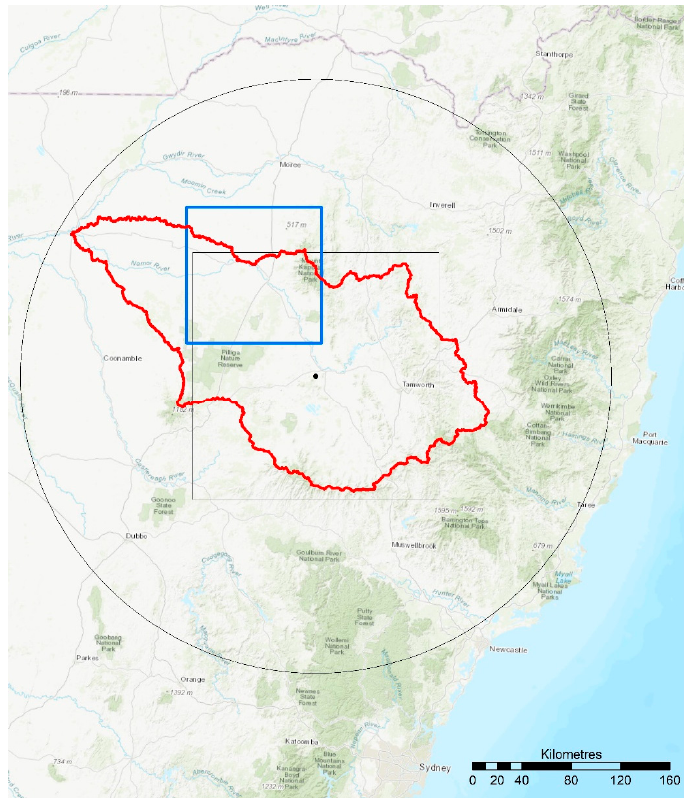
Figure 1. Map of the Namoi catchment and its surrounding. Depicted are the catchment (red line), the location of Namoi radar (black dot), the radar coverage after processing (radius of 240 km; black circle), the area used for the comparison of the different precipitation datasets with respect to spatial precipitation patterns (black rectangle) and the area used for the evaluation of the soil moisture data (blue rectangle).